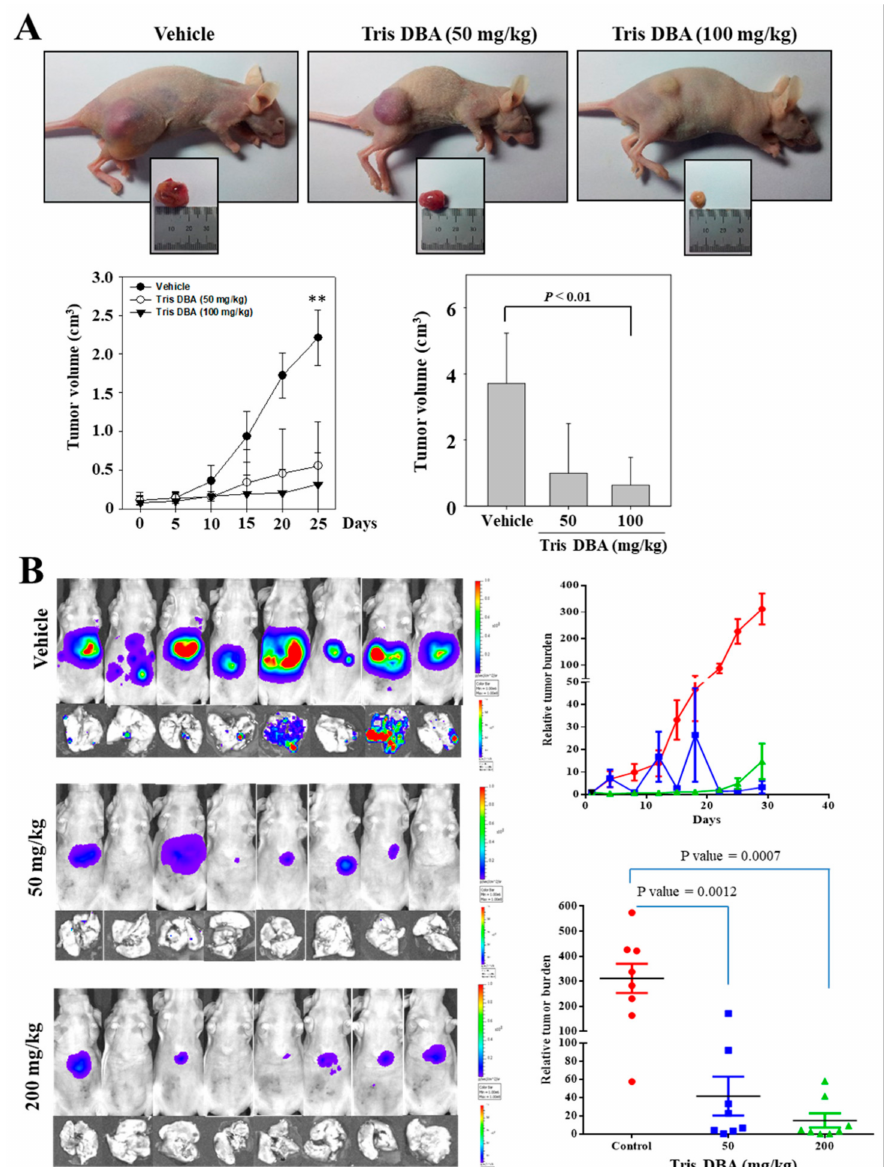
Figure 7. Tris DBA induces antitumor activity in xenograft MM and the orthotopic HCC mice model. ( A ) U266 cells were subcutaneously injected into xenograft tumors. After tumors reached 0.25 cm in diameter, the mice were divided into three groups (n = 6/group) and administered with 50 mg or 100 mg/kg body weight. The tumor volume was monitored throughout the study tenure. ( B ) HCCLM3-Luc cells-induced tumors are orthotopically implanted to the liver tissue followed by treatment with 0.1% DMSO ( n = 7) or Tris DBA ( n = 7) (administered 50 mg/kg or 200